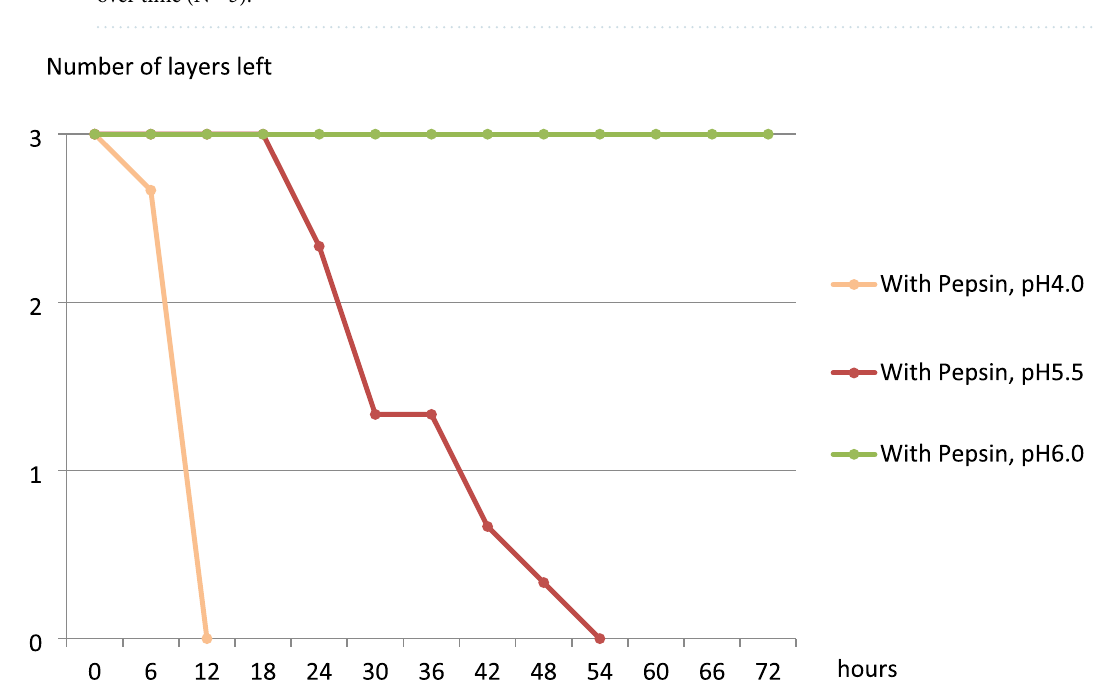
Figure 5. Change in the mean number of the remaining layers in the pH 4.0, pH 5.5, and pH 6.0 with pepsin groups over time (N =